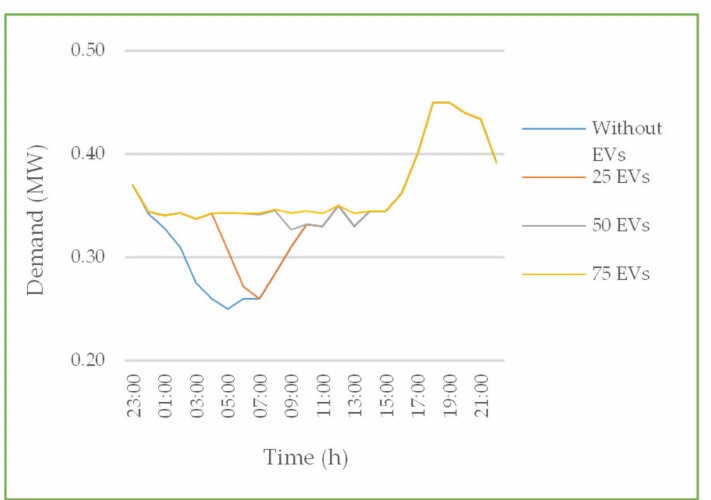
Figure 3. The effect of charging on load curve 1 (LC1) when N = 25, 50 and 75 cars are used for valley filling anytime during the day.